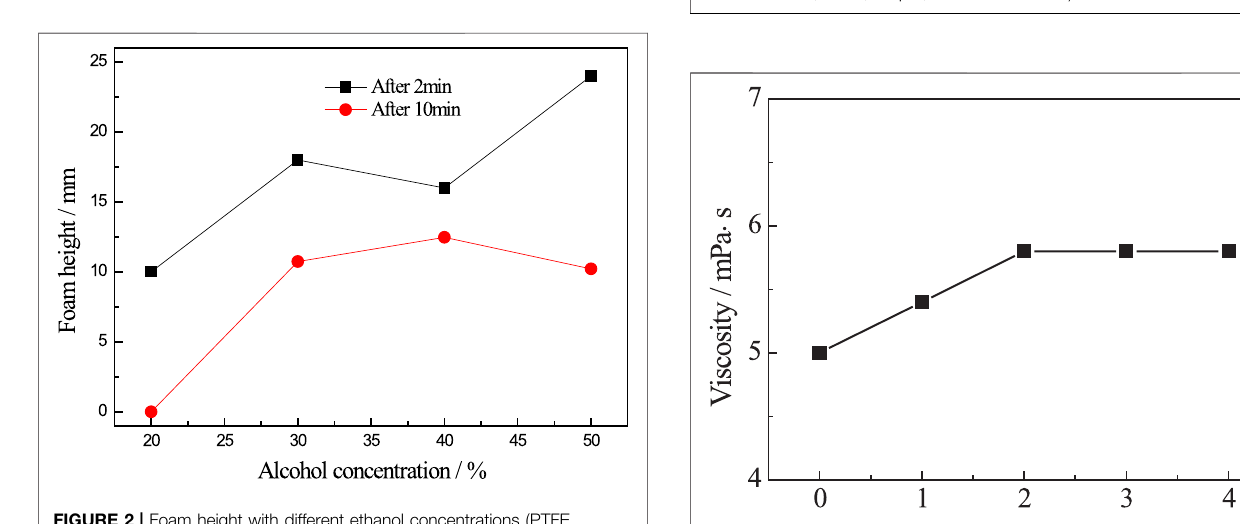
FIGURE 2 | Foam height with different ethanol concentrations (PTFE, 20 μ m, 1.0 wt%).